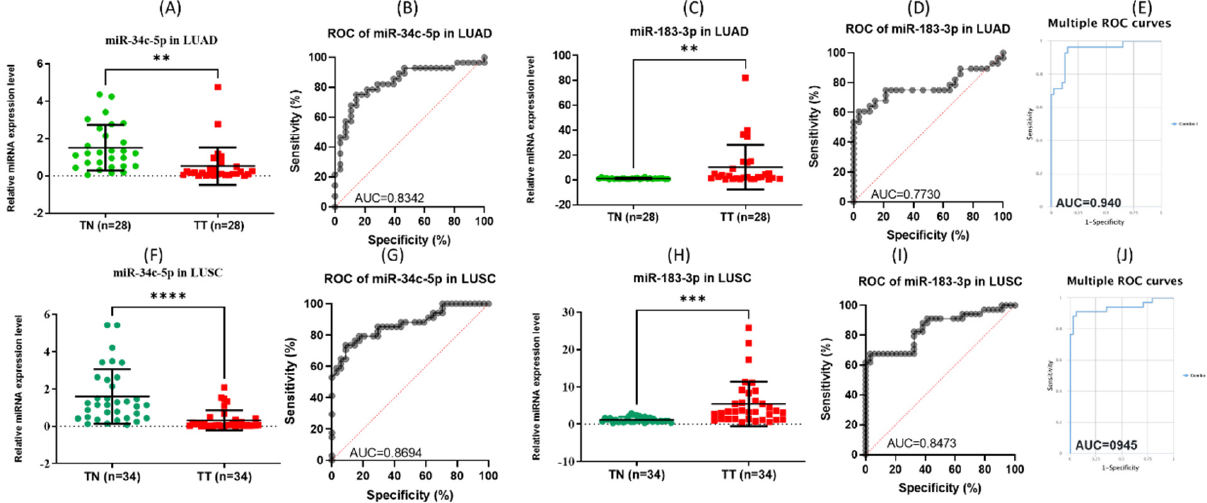
Figure 5. Tissue qRT-PCR data validation for miR-34c-5p and miR-183-3p in NSCLC. ( A ) miR-34c-5p expression levels in LUAD. ( B ) ROC curve for miR-34c-5p in LUAD. ( C ) miR-183-3p expression levels in LUAD. ( D ) ROC curve for miR-183-3p in LUAD. ( E ) Combined ROC curves for miR-34c-5p and miR-183-3p in LUAD, generated using CombiROC online tool. ( F ) miR-34c-5p expression levels in LUSC. ( G ) ROC curve for miR-34c-5p in LUSC. ( H ) miR-183-3p expression levels in LUSC. ( I ) ROC curve for miR-183-3p in LUSC. ( J ) Combined ROC curves for miR-34c-5p and miR-183-3p in LUSC, generated using CombiROC online tool (** p ≤ 0.01, *** p ≤ 0.001, **** p ≤ 0.0001).